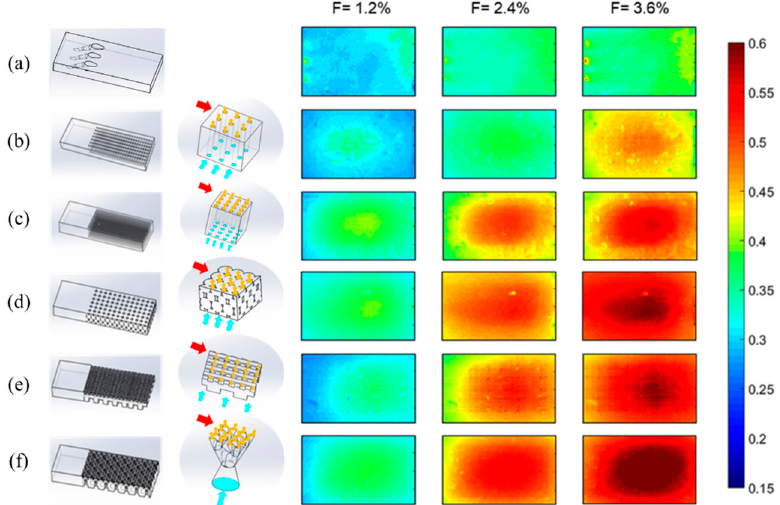
Figure 34. Cooling efficiency of six types of cooling configurations: ( a ) laidback fan-shaped cooling holes, ( b ) round holes with pitch of 3 d , ( c ) round holes with pitch of 2 d , ( d ) spheres packing, ( e ) wire mesh, and ( f ) blood vessel shaped structure. Adapted with permission from [127]. Copyright 2019